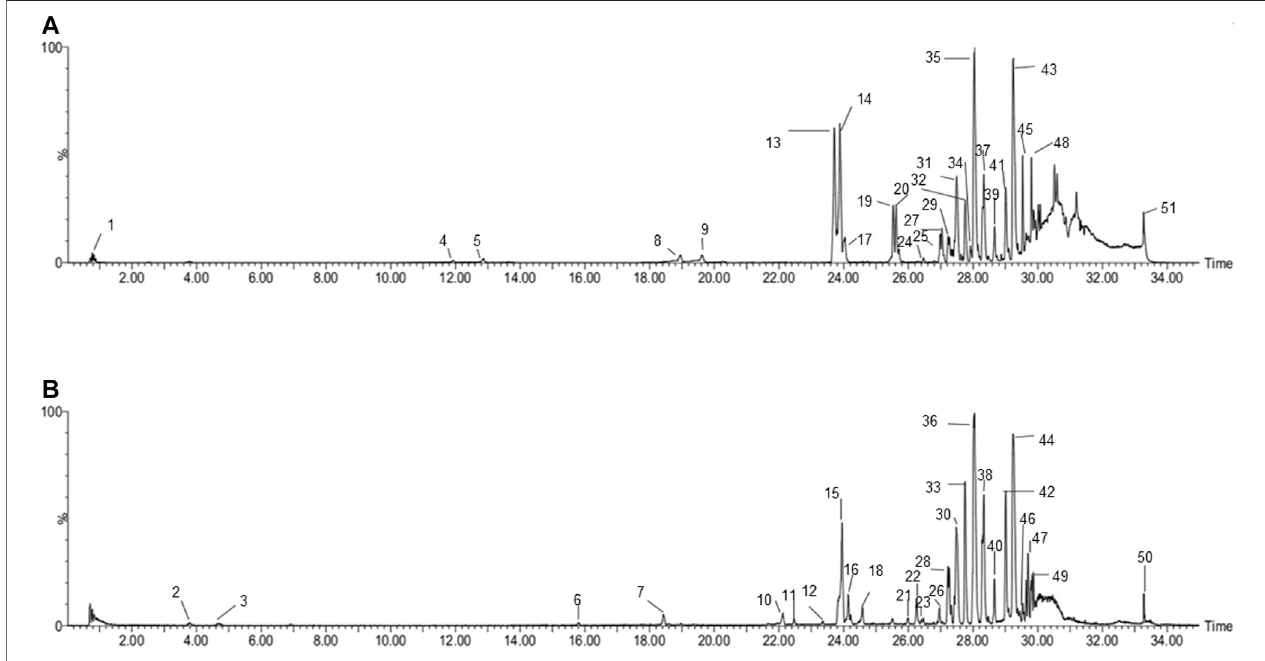
FIGURE 2 | BPI chromatograms of XPF in serum sample in positive (A) and negative. (B) Ion modes determined by UPLC-Q-TOF/MS.